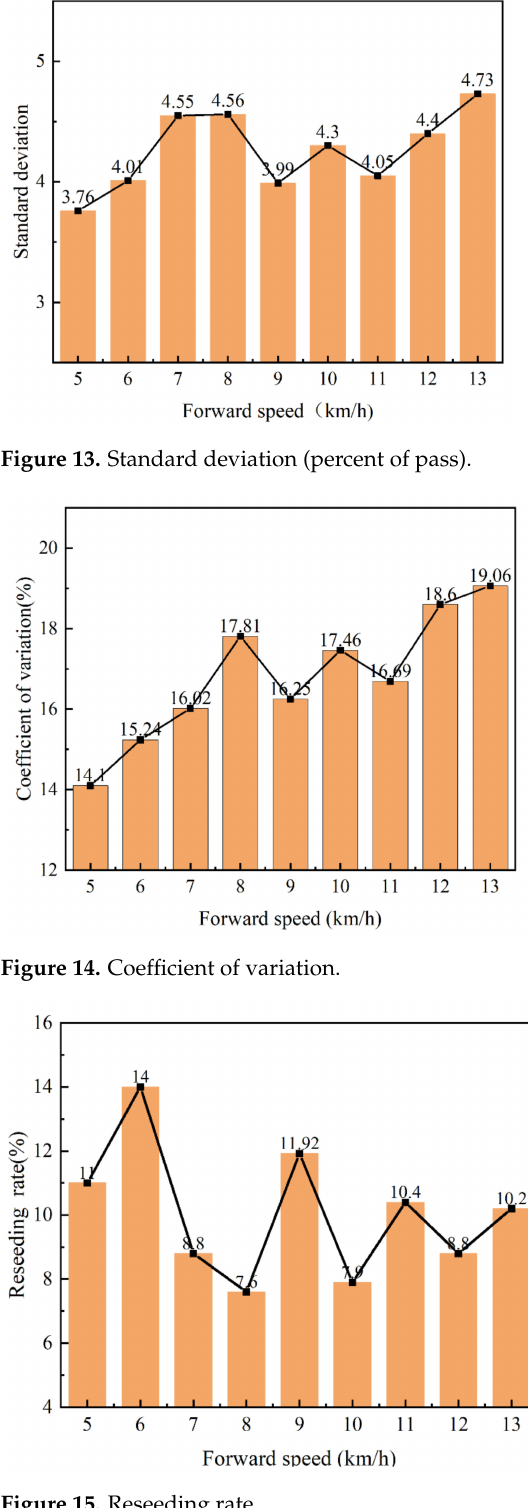
Figure 15. Reseeding